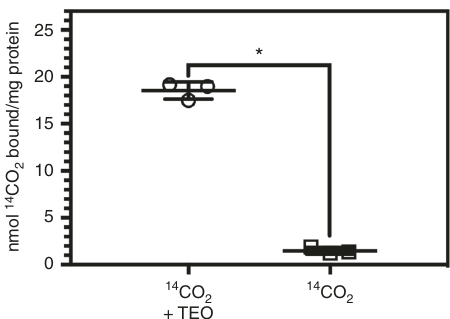
Fig. 6 Identi fi cation of exchangeable CO 2 -binding site on Arabidopsis protein extract. 14 CO 2 trapped onto protein extract of Arabidopsis thaliana (* p < 0.0001, two-tailed t -test, n = 3 independent replicates, t = 29.85, d f = 4, ±S.E.M.)